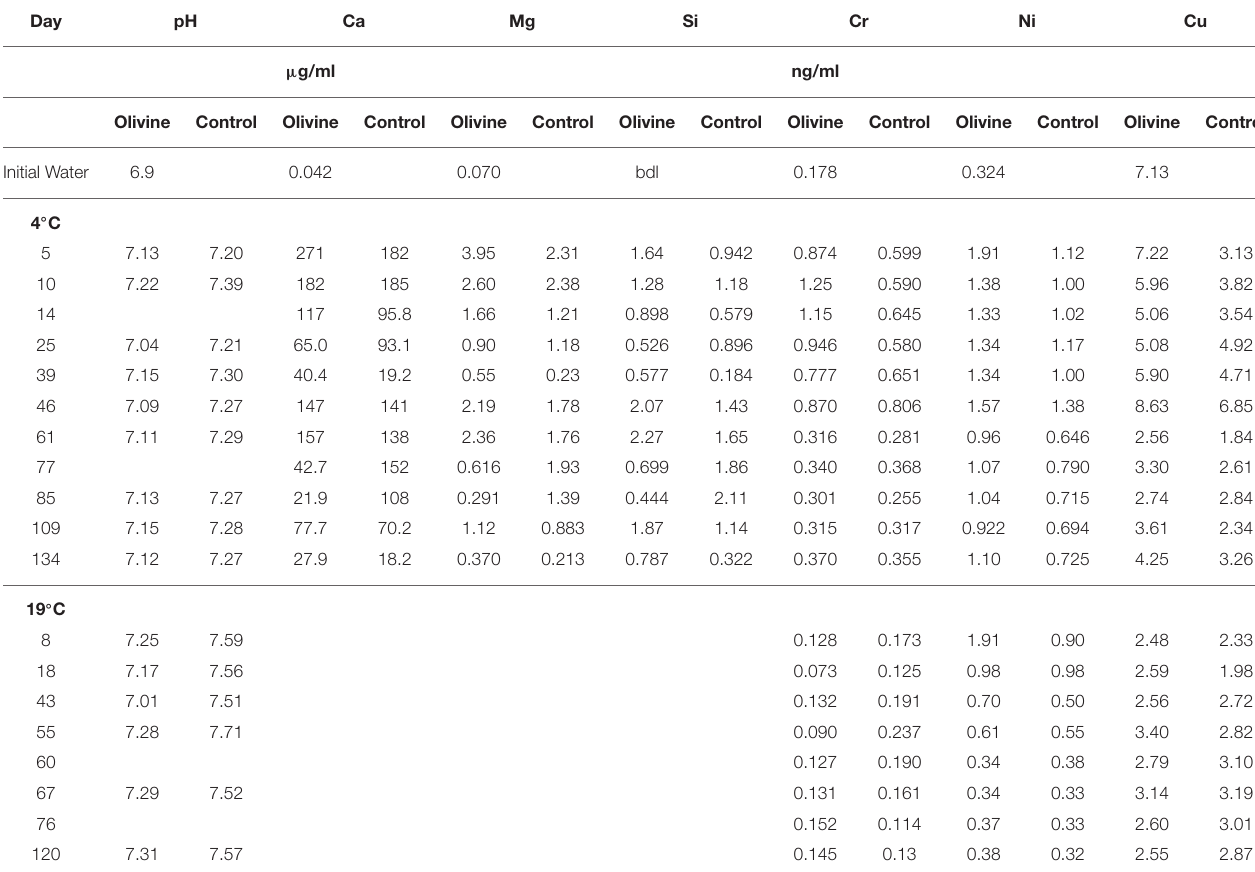
TABLE 1 | Elemental concentrations from the 4 ◦ C experiments, and the heavy metal concentrations also from the 19 ◦ C experiment. Day pH Ca Mg Si Cr Ni Cu µ g/ml ng/ml Olivine Control Olivine Control Olivine Control Olivine Control Olivine Control Olivine Control Olivine